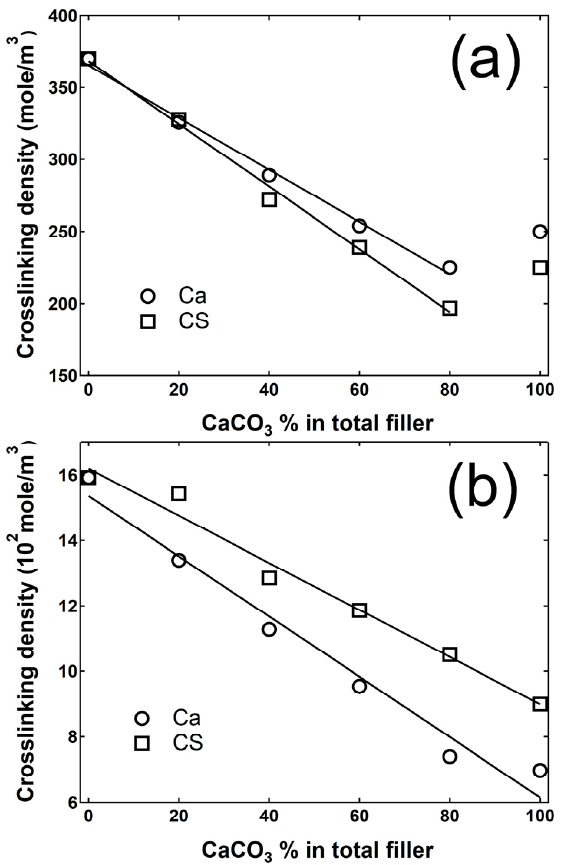
Figure 1. Crosslink densities of protein and calcium carbonate reinforced NR (natural rubber) with 50 phr filler. ( a ) Swelling method. ( b ) Plateau moduli method.